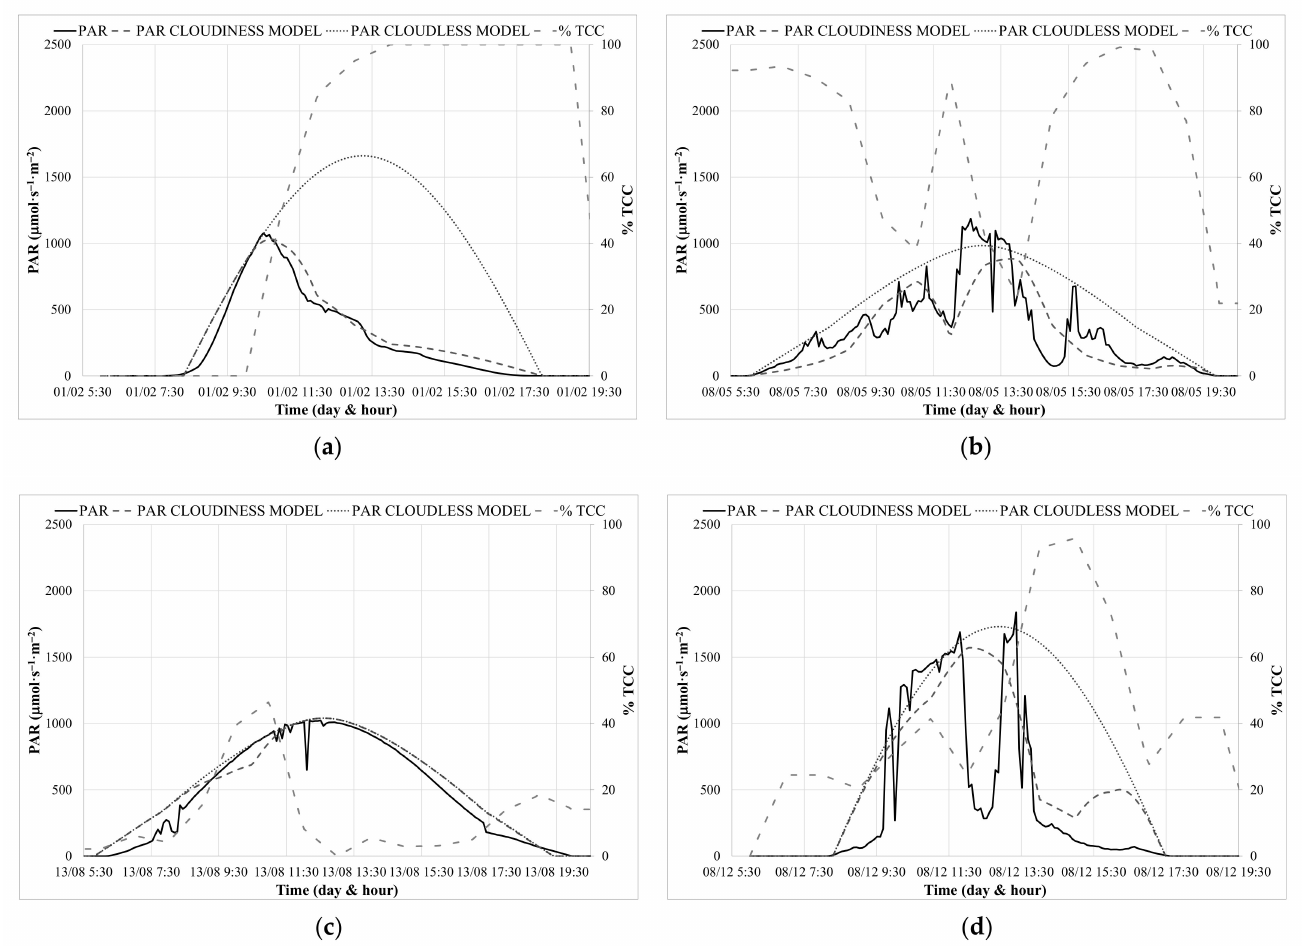
Figure 6. PAR TCC model performance for several days: ( a ) winter; ( b ) spring; ( c ) summer; and ( d )